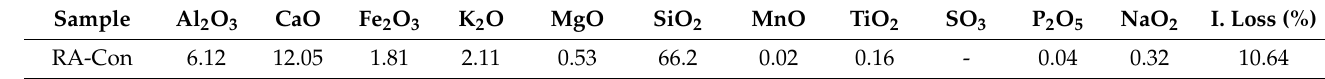
Table 3. Elemental analysis of aggregates by X ‐ ray fluorescence.